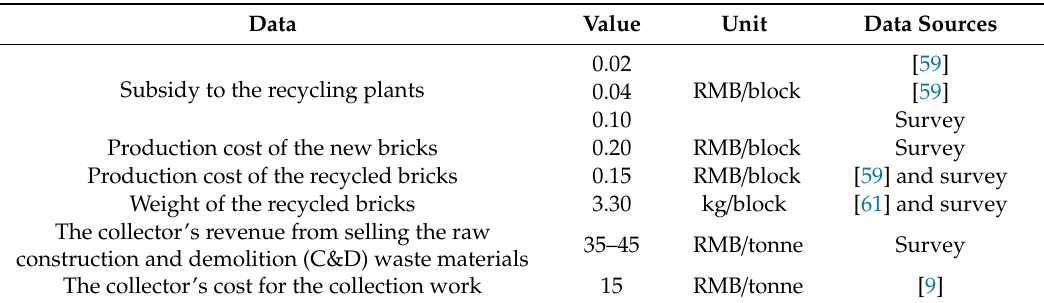
Table 2. Data of the numerical